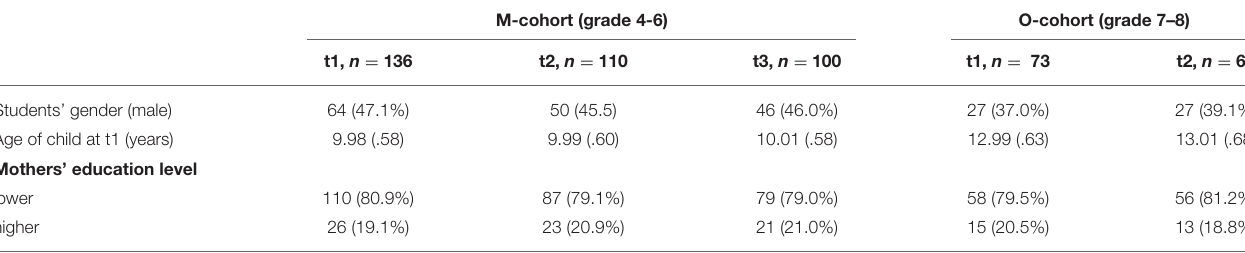
TABLE 1 | Demographic characteristics of the study participants.